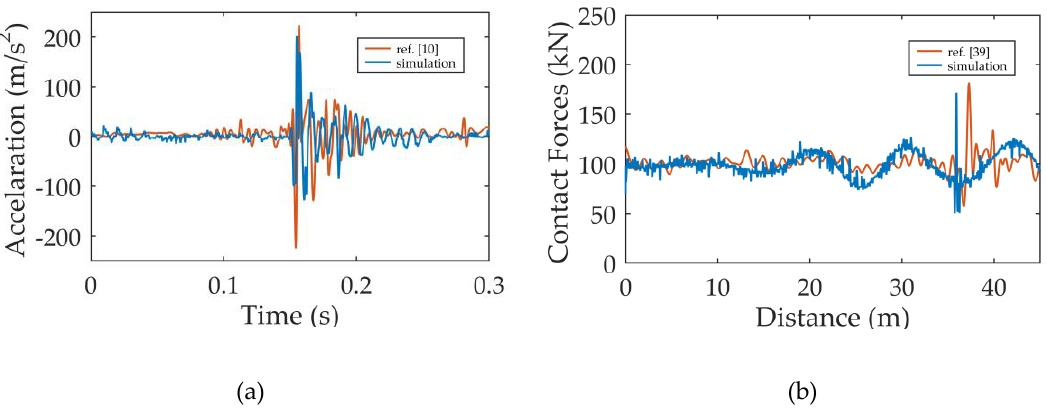
Figure 3. Multibody simulation and field data: ( a ) Vertical acceleration of the front wheel for comparison [10]; ( b ) normal contact forces along a turnout for comparison [39] .